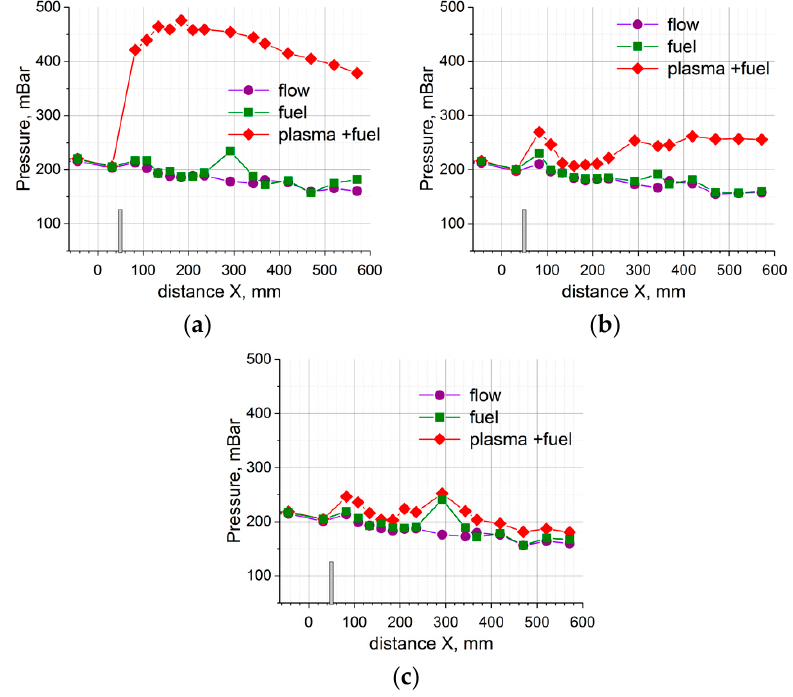
Figure 14. Typical wall pressure distributions for three cases: ( a ) strong combustion; ( b ) weak combustion; ( c ) partial fuel oxidation.